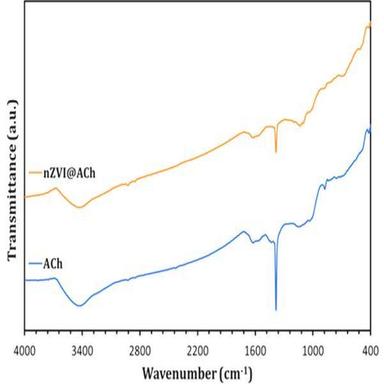
FTIR spectra of the ACh and nZVI@ACh composite.